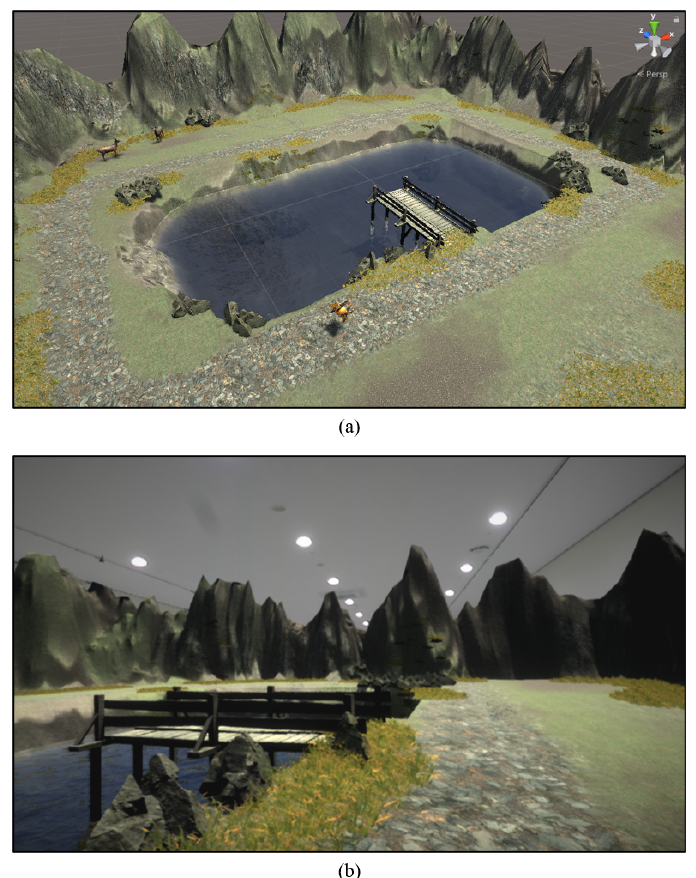
Figure 9. MR flight environment of the drone player: ( a ) bird’s-eye view; ( b ) as seen by the